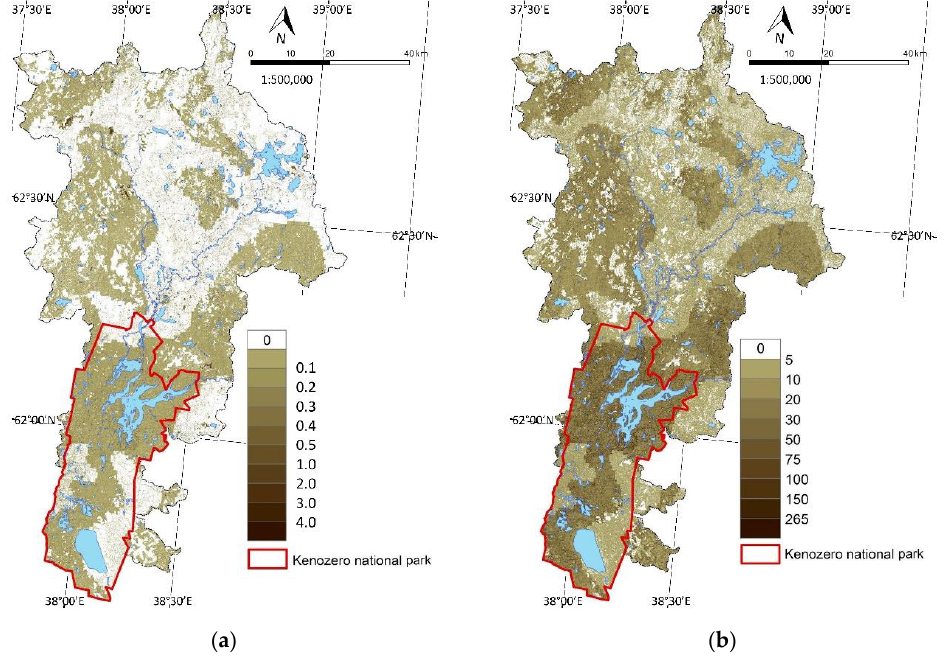
Figure 6. ES of prevention of soil erosion and soil flushing into water bodies: ( a ) annual soil loss in 2007 (t/ha/year); ( b ) avoided erosion (t/ha/year).